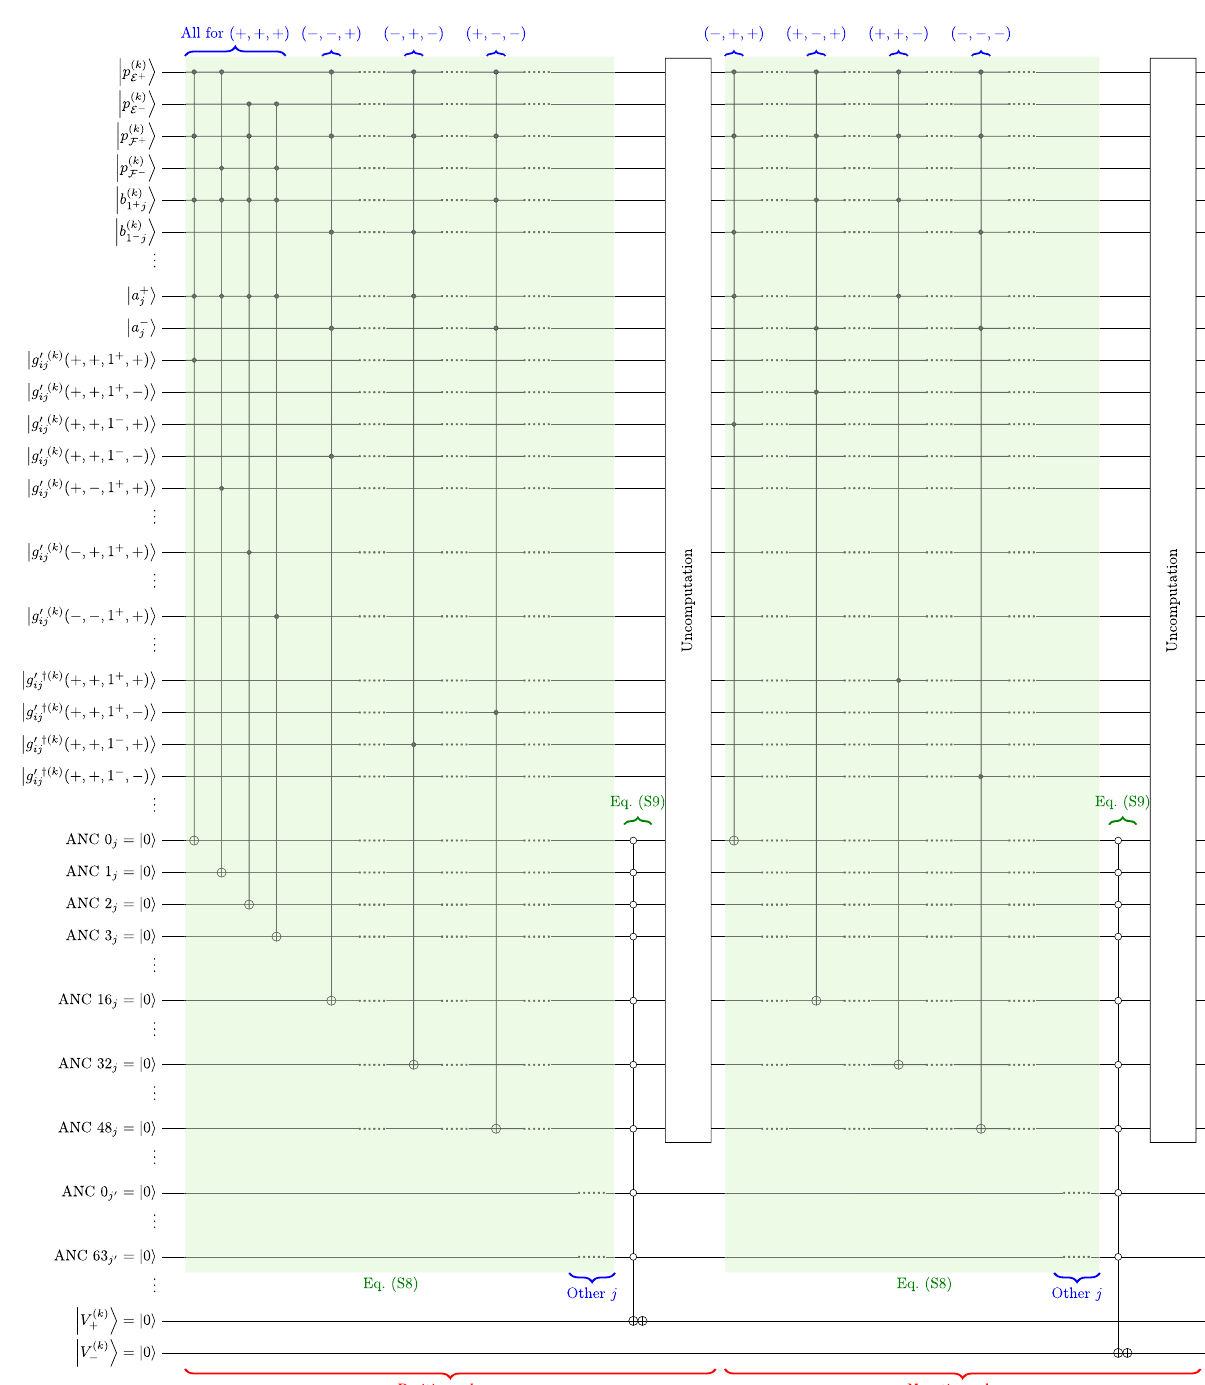
, , ) annotation · · · p ( k ) E p ( k ) F and for ± (cid:30) ± (cid:30) (cid:31) (cid:31) p ( k ) E p ( k ) F and (cid:31) (cid:31) + (cid:30) + (cid:30) is shown for conciseness. This figure corresponds to Eqs. (S8) and (cid:31) (cid:31) (cid:31) (cid:31)